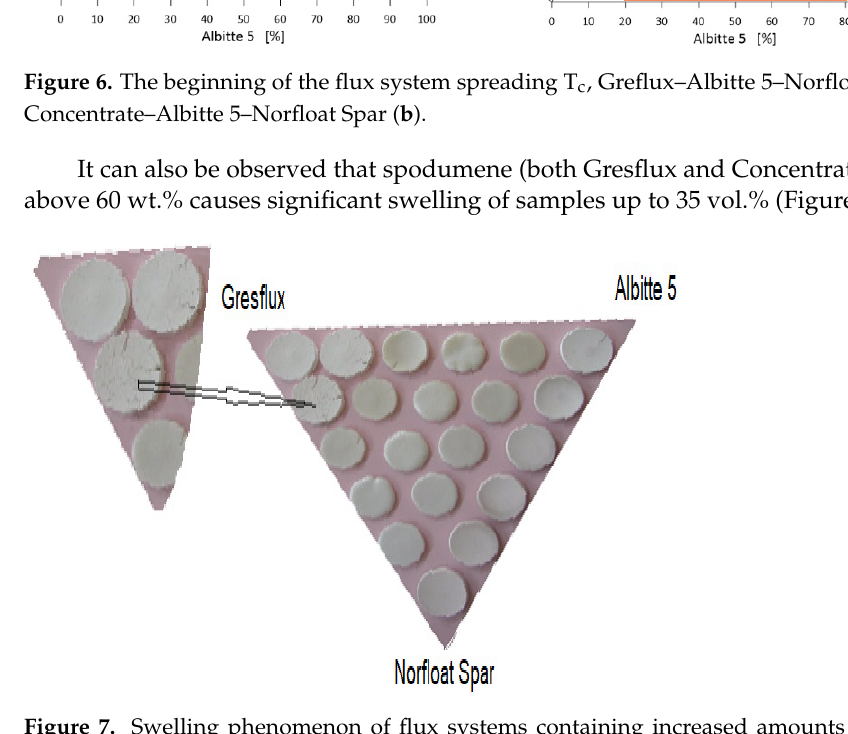
Figure 7. Swelling phenomenon of flux systems containing increased amounts of spodumene, (diameter of the pastille was 5 cm).